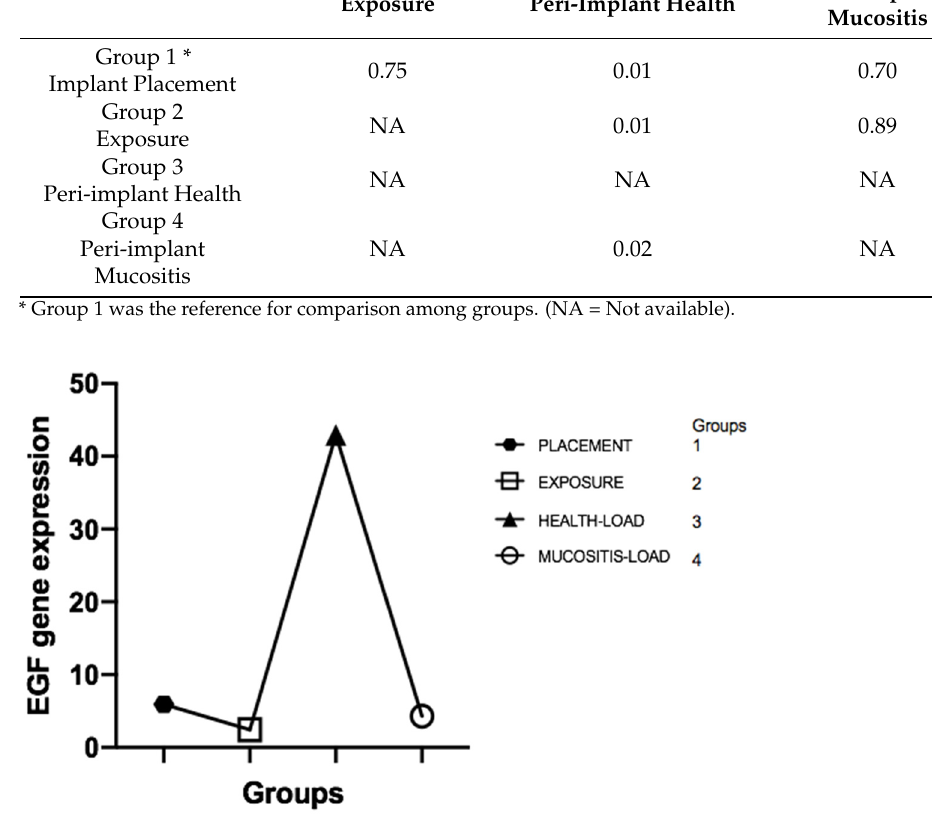
Figure 3. EGF gene expression in the groups, showing the high levels of EGF in Group 3 compared to the other groups. Table 3. The p -values in the comparison between the groups, considering the EGF gene expression.